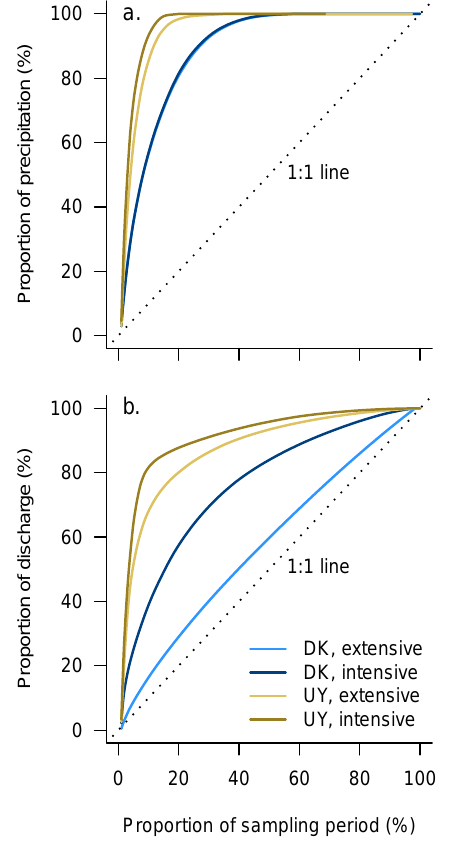
Figure 1. Ranked precipitation (a) and discharge values (b) versus the proportion of the sampling period. Precipitation data for both the intensive and extensive catchment in Denmark are included but are very similar. The 1:1 line represents a completely equal precip- itation (a) or discharge (b) across the whole sampling period. Plot style adapted from Dalzell et al.